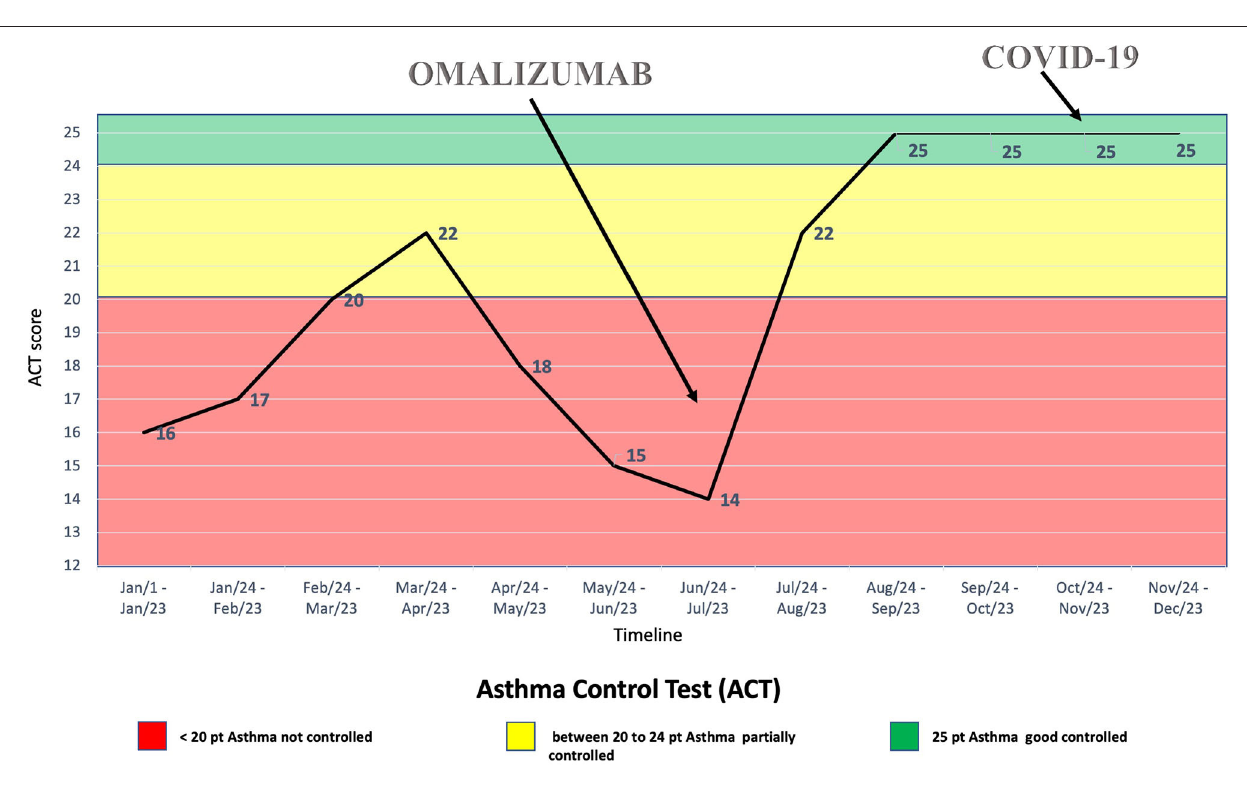
FIGURE 2 | Summary of the Asthma Control Test recorded with the patient over